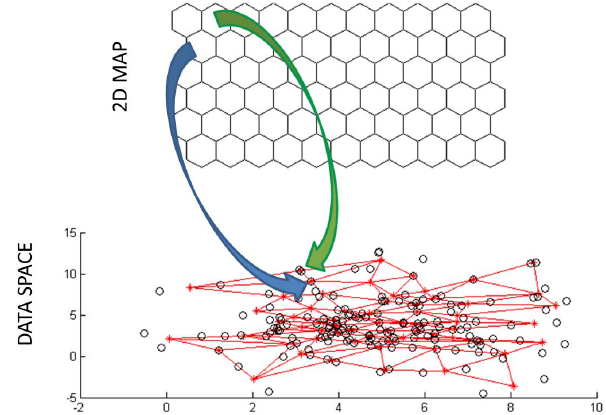
Figure 5. On top we have a representation of the topological map as a lattice, while on the bottom we have a projection of data in the data space (black circles), as well as the average values of each class (red circles). Adjacent classes on the SOM lattice correspond to adjacent areas in the multidimensional data space. The red lines indicate the connections between neighbouring